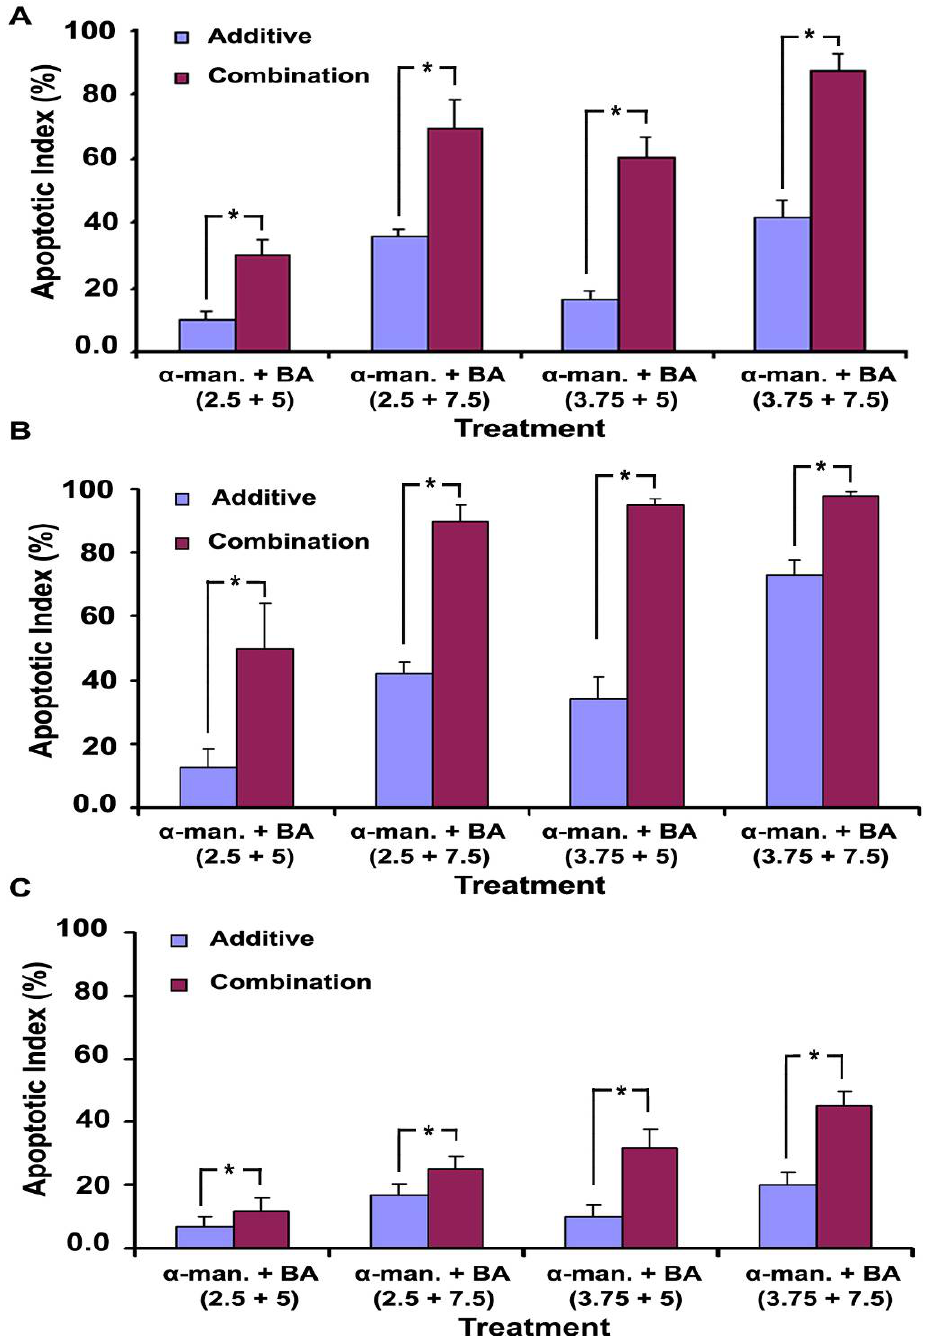
Figure 7. Apoptotic index of the combinations of α -mangostin and betulinic acid (BA) on HCT 116 cells. The effect on cellular morphology ( A ), the loss of mitochondrial membrane potential ( B ), and the chromatin condensation ( C ). The combination effect was compared to the additive effect by student’s t -test, and ( * ) refers to P values <